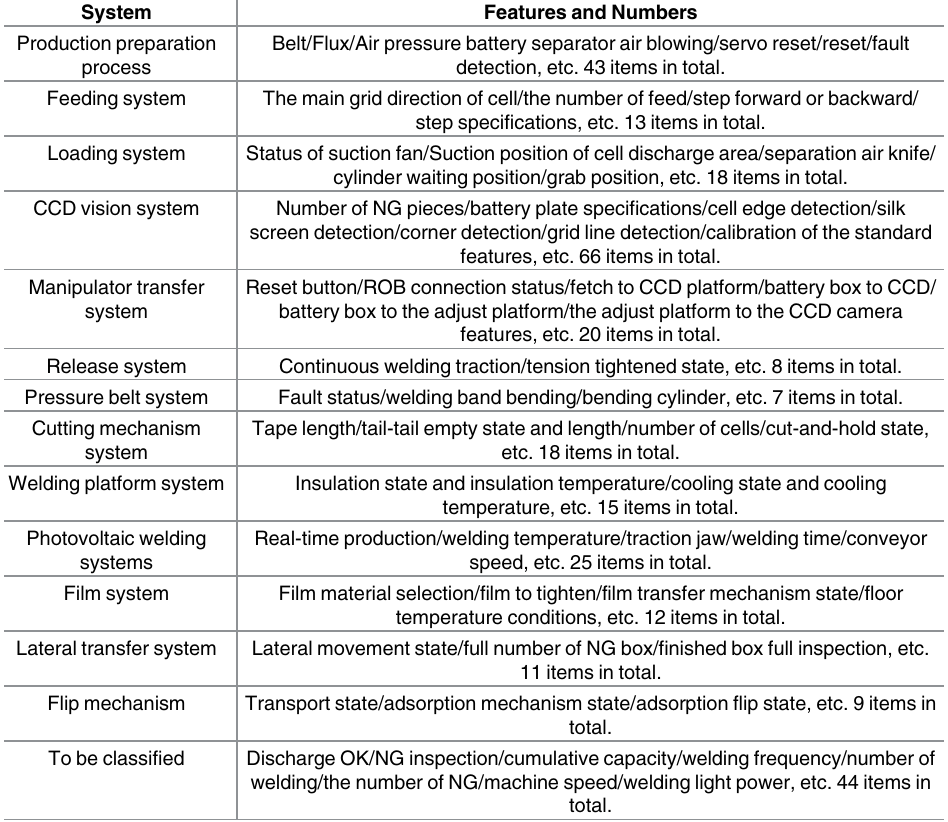
Table 1. The features of the production